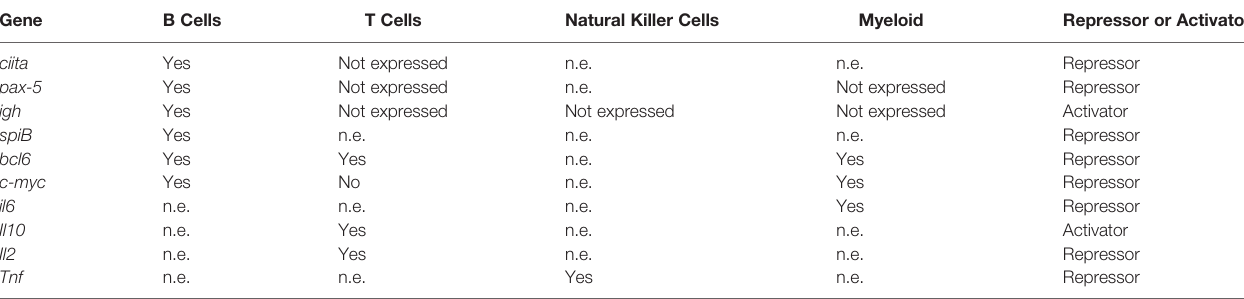
TABLE 1 | Conserved and unique targets of Blimp1 transcriptional regulation.